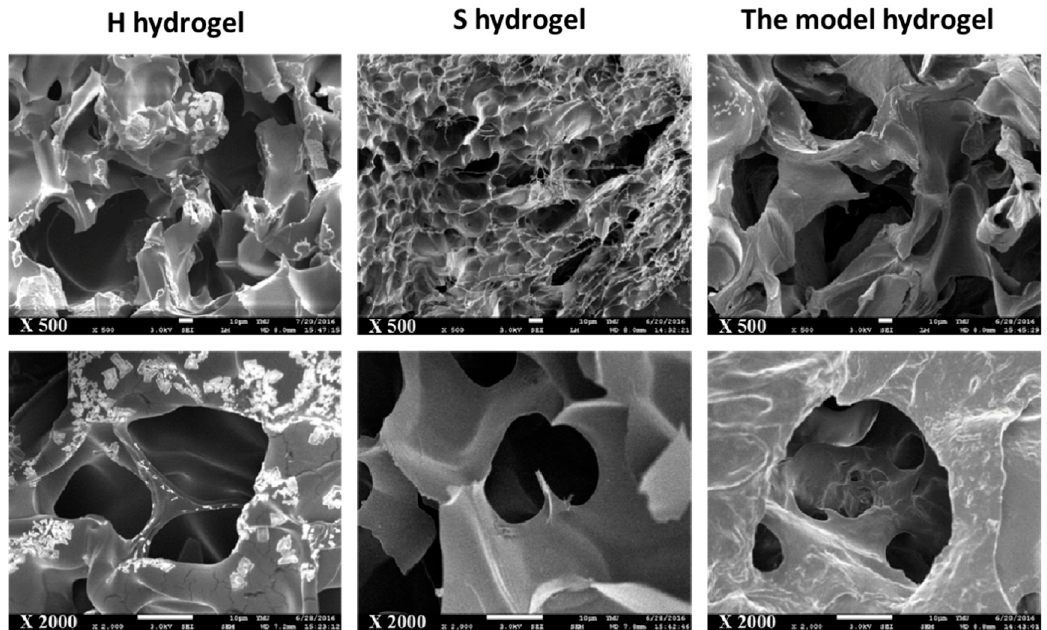
Figure 2. SEM micrographs of H, S, and HS-IPN hydrogels. The pore size of the model hydrogels was 38.96 ± 5.05 µ m, ( n = 3), in between those of H and S hydrogels.